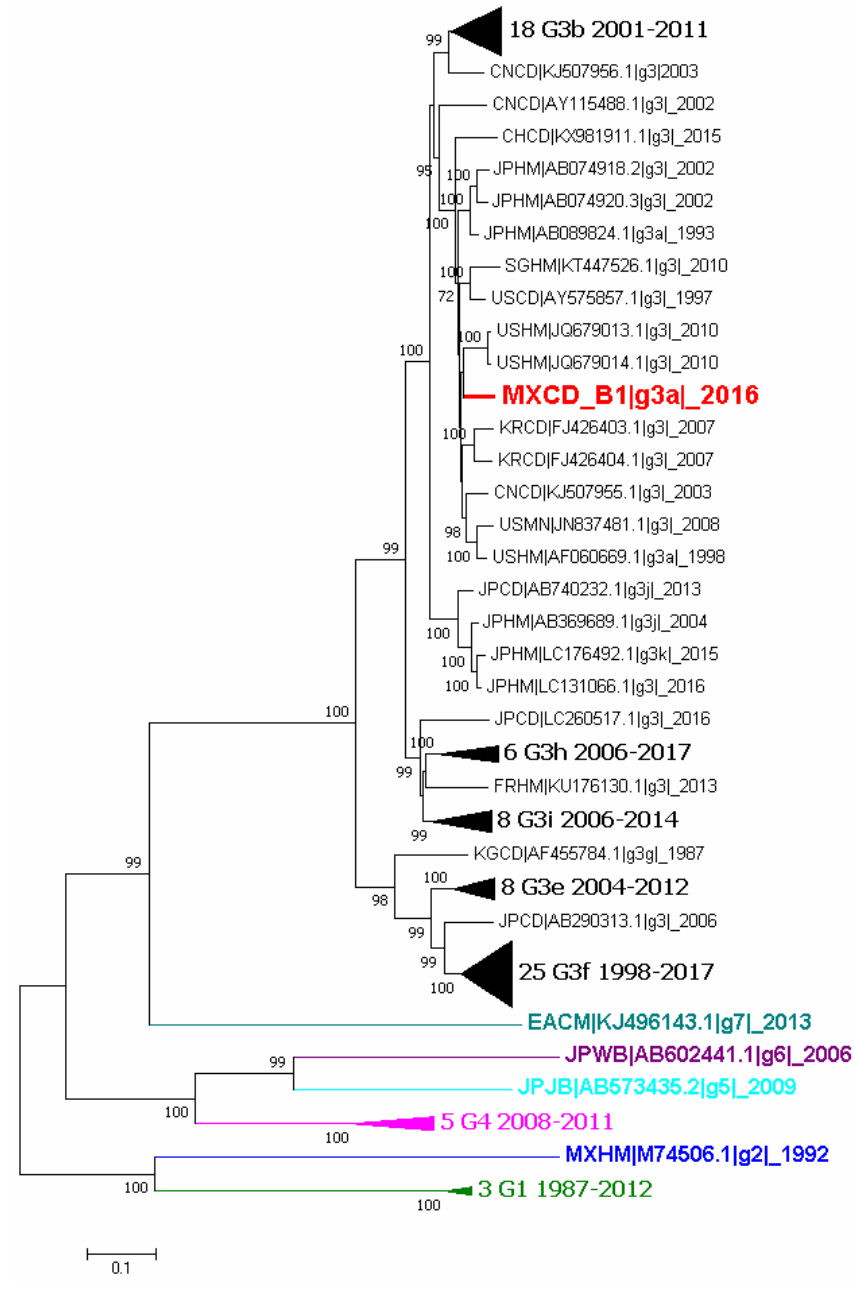
Figure 2. Phylogenetic tree of all available complete genome sequences of hepatitis E virus (HEV). Analysis included 101 nucleotide sequences (CD-HIT 98%). Relationship was inferred by the maximum likelihood method based on the GTR model with gamma distribution and 1000 bootstrap. Branches were clustered to construct the graph. The first number indicates the number of sequences, genotype and subgenotype, and year of detection. Black triangles symbolize clustering of similar sequences identified by number of sequences, genotype and years of report. Colors represent different genotypes, blue for genotype 2, green for genotype 3, magenta for genotype 4, cyan for genotype 5, purple for genotype 6 and light blue for genotype 7.